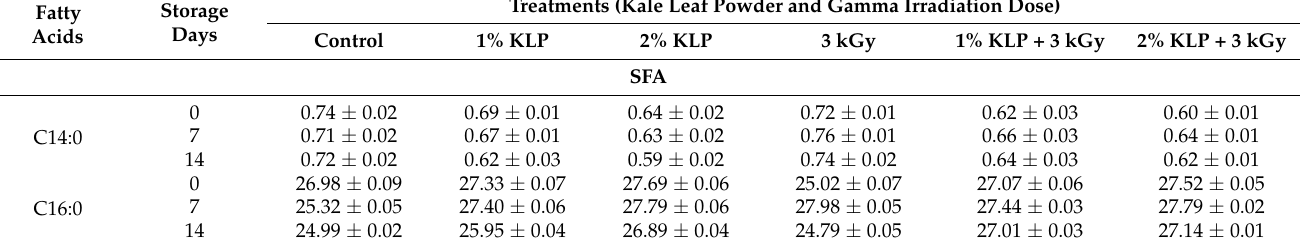
Table 3. Fatty acid composition (%) of chicken meat treated with kale leaf powder and gamma irradiation at different storage